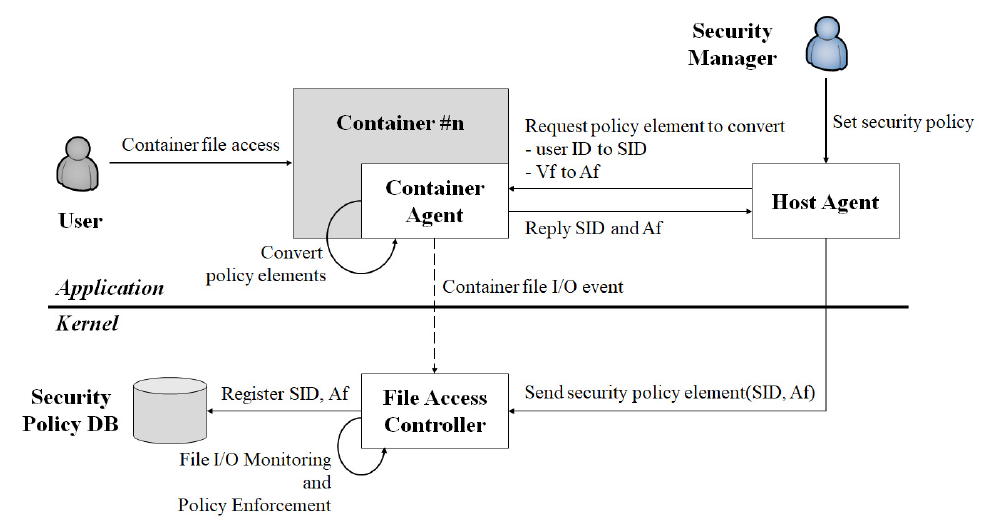
Figure 6. Schematic of the container file access control architecture.